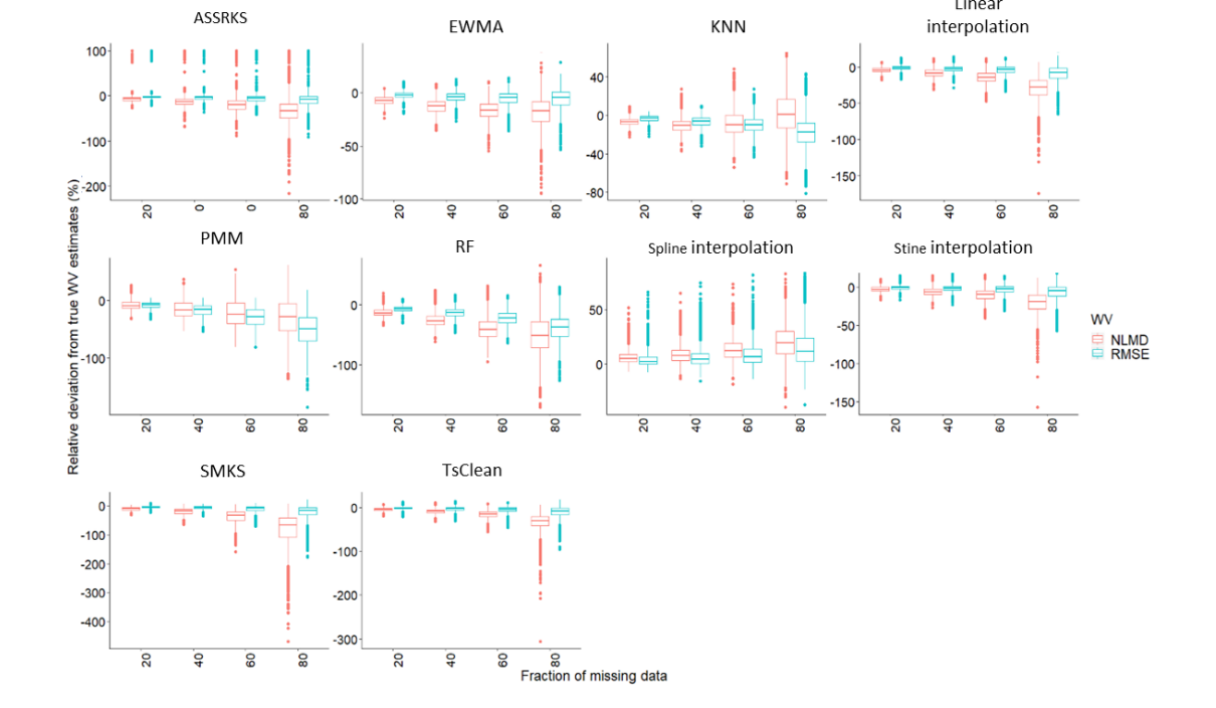
Figure 4. Influence of data imputation on linear and non-linear body weight variability estimates. Caption: Boxplots of the relative errors associated with calculation of body weight variability in body weight data collected by smart scales when using 10 different imputation methods imputing data in increments of 20%, 40%, 60%, and 80%. Errors represent the deviation from estimates made from observed data sets. ASSRKS: ARIMA state-space representation and Kalman smoothing; EWMA: exponentially weighted moving average; KNN: K-nearest neighbors; NLMD: nonlinear mean